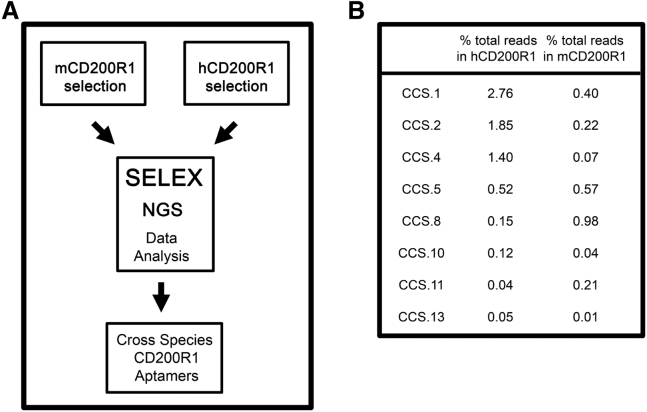
Next-Generation Sequencing Performed on Separate Human and Murine CD200R1 SELEX Screens(A) The selection strategy to identify to the presence of identical aptamer motifs. (B) The percentage of total sequence reads of each cross-reactive aptamer obtained from NGS sequence analysis. hCD200R1, human CD200R1; mCD200R1, murine CD200R1.